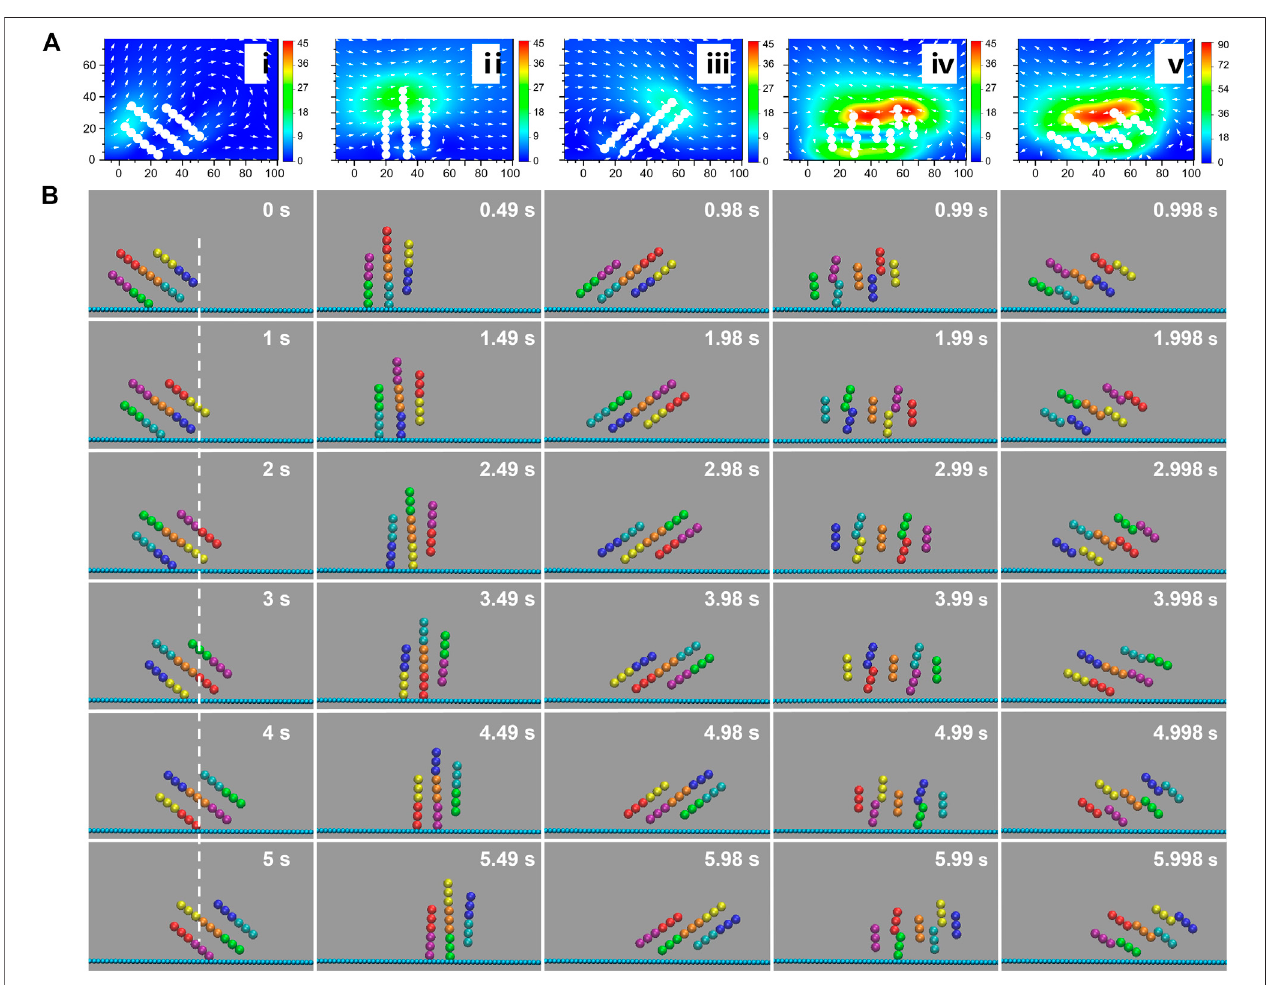
FIGURE 2 | Locomotion mechanism of vertical wheel-like swarm. (A) Flow fi eld distribution surrounding magnetic chains actuated by synthetic magnetic fi eld of amplitude ratio γ = 3 and frequency f = 1 Hz. The color pro fi le indicates the magnitude of the velocity fi eld. (B) Dynamic sequence pro fi le of a vertical wheel-like swarm energized by synthetic magnetic fi eld of γ = 3 and f = 1 Hz. Trimers in diverse colors indicate different magnetic units.